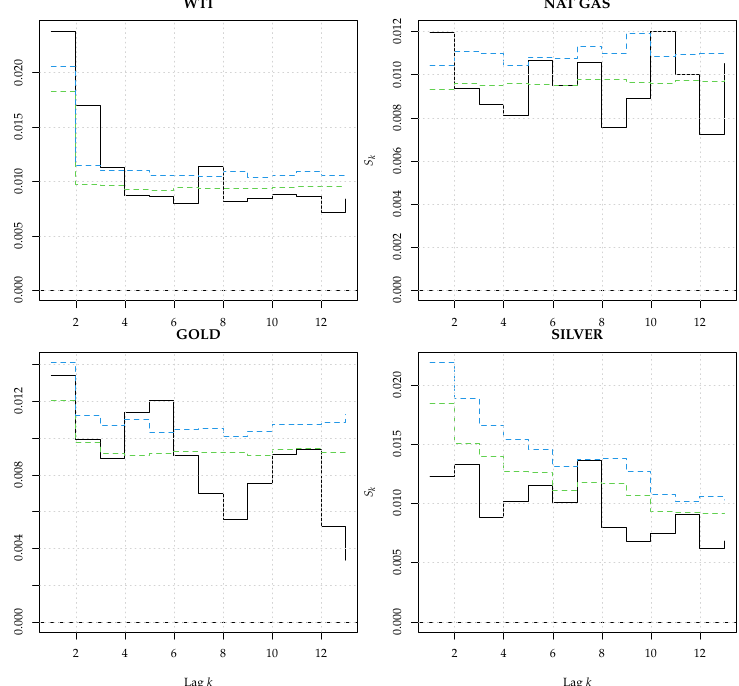
Figure 19. Serial entropy S k for lag k = 1, . . . ,13 (black, solid line), computed on the commodity price series. The rejection bands at 95% (green dashed line) and 99% (blue dashed line) correspond to the null hypothesis of a general linear